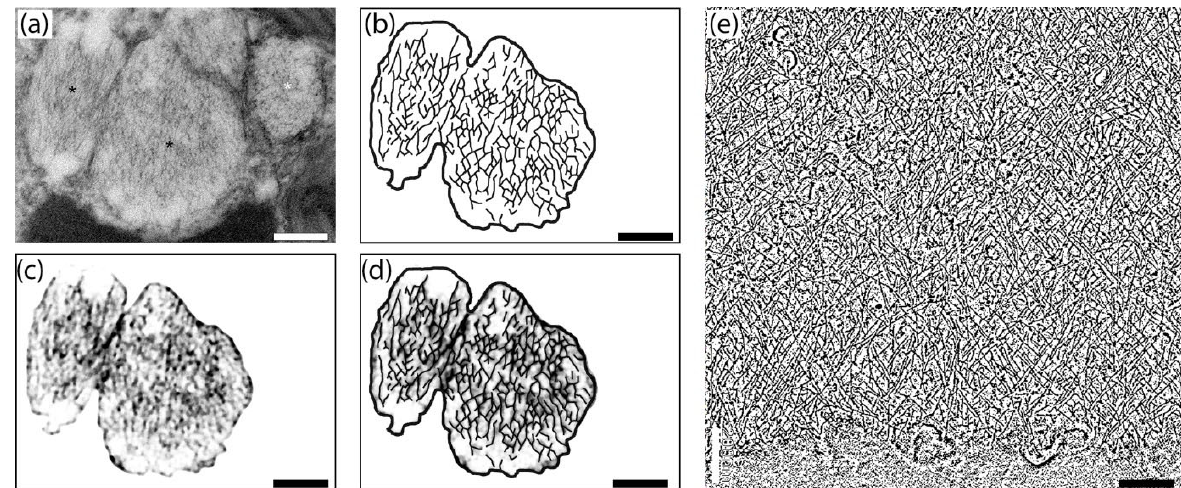
Figure 7. Comparison of internal nanostructure of fibrillar vesicles (a–d) to actin meshwork (e) (scale bar 200nm). (a) TEM image of a fibrillar vesicle, reprinted from LeKieffre et al. (2018a), with permission from Elsevier (their Fig. 14). (b) Model of geometry of fibrillary structures inside fibrillar vesicle based on panel (a) . (c) The first step in drawing the model shown in (b) . A fragment of panel (a) with the background removed and processed in FIJI software in order to make the geometry more apparent. (d) Overlay of panel (c) with a sketch of the internal structure of FB drawn in CorelDraw. (e) The structure of actin meshwork in lamellipodia based on a nano-tomograph reprinted from Mueller et al. (2017), with permission from Elsevier (their Fig. 4b, modified).